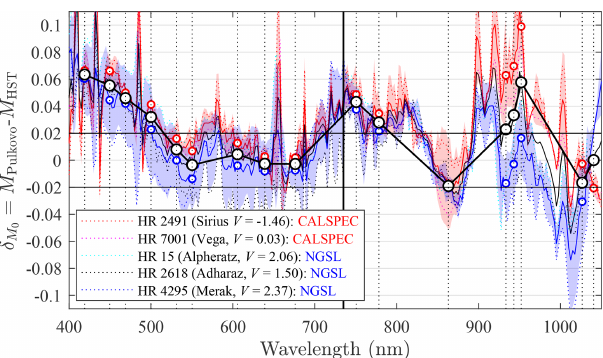
Figure 4. Spectrophotometric bias ( δM 0 ) of the Pulkovo cata- logue with respect to two different HST catalogues (CALSPEC and NGSL). Open circles represent our standard starphotometer chan- nels, solid coloured lines are δM 0 averages for each HST catalogue, and the coloured shading represents the corresponding standard de- viations. For each spectrum point, the two coloured curves and their shading represent sampling populations of two points (stars) for the red CALSPEC catalogue and three points (stars) for the blue NGSL catalogue: our objective here was to obtain an estimate of δM 0 statistics assuming δM 0 values were roughly independent of the M 0 values of individual stars.